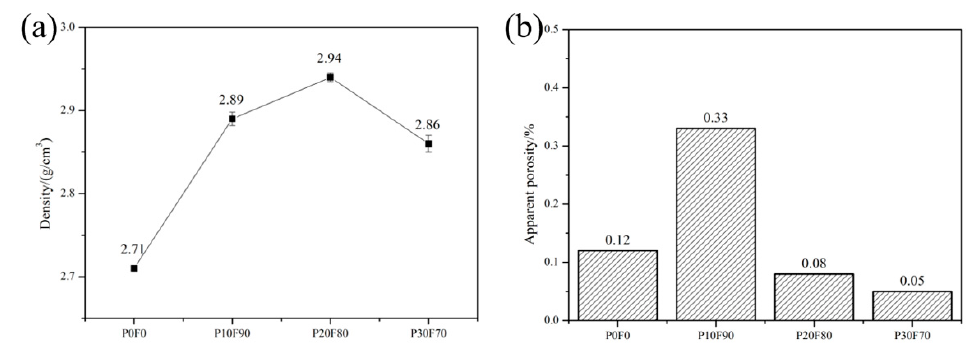
Figure 10. Compare and demonstrate the performance of P0F0, P10F90, P20F80 and P30F70: ( a ) bulk density, ( b ) apparent density, ( b ) apparent porosity.